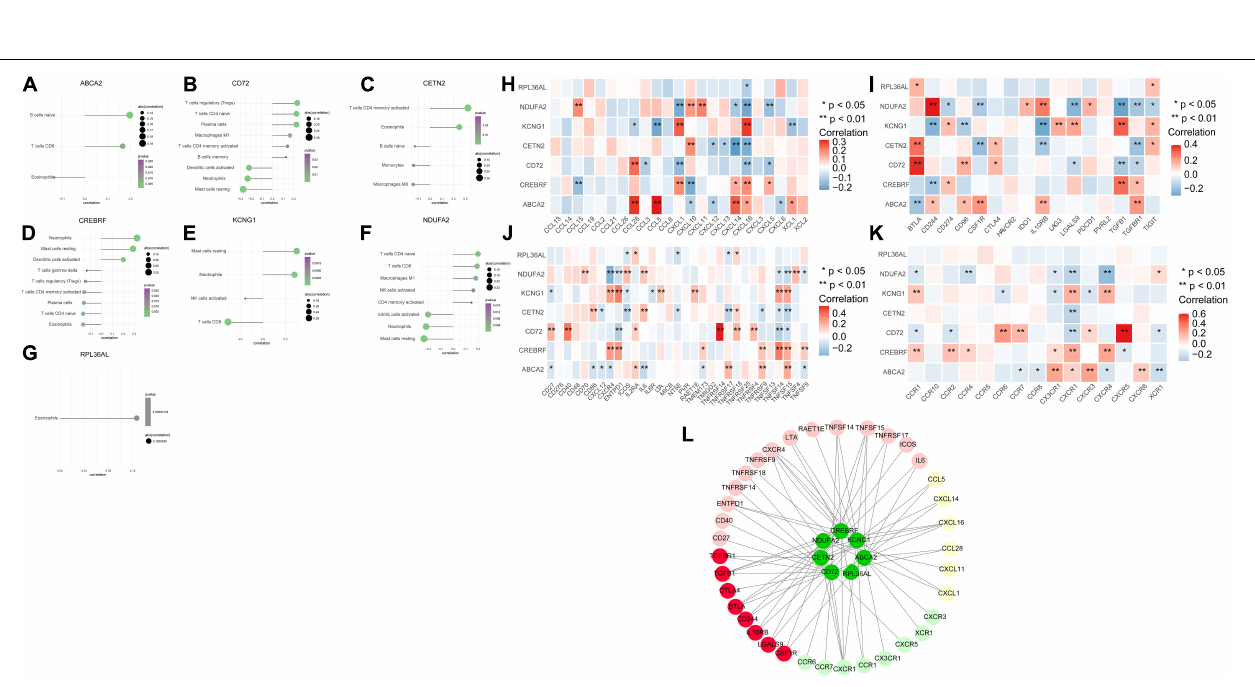
FIGURE 3 | The association between the hub genes and immune cell infiltration. (A–G) Correlations between hub genes and the infiltration level. (H–K) Correlation between hub genes and chemokines, immunosuppressive factors, immunostimulatory factors, and immune receptors. (L) Protein–protein interaction plot of hub genes and immune-related